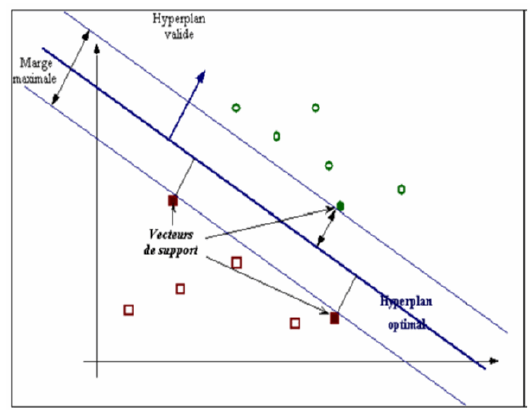
Figure 9. Principe de la classification SVM (Mohamadally et Fomani 2006)